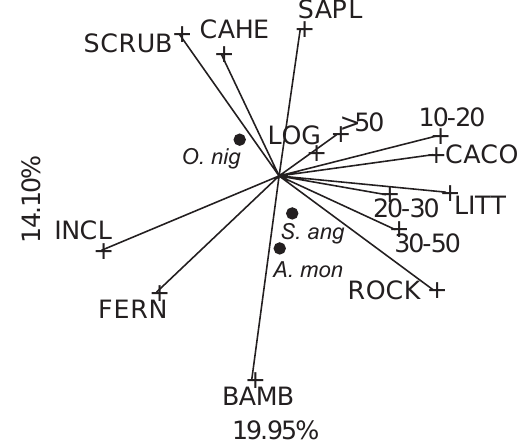
Figure 2. Principal component analysis of microhabitat variables (active variables, represented by crosses) and abundances of the three most common rodents (supplementary variables, represented by filled circles).Variable abbreviations: (10-20) number of trees between 10 and 20 cm of perimeter at breast height (PBH); (20- 30) number of trees between 20 and 30 cm of PBH; (30-50) num- ber of trees between 30 and 50 cm of PBH; (>50) number of trees larger than 50 cm of PBH; (CACO) canopy cover above trapping station; (CAHE) canopy height above trapping station; (LOG) fallen logs; (BAMB) abundance of bamboos; (FERN) abundance of